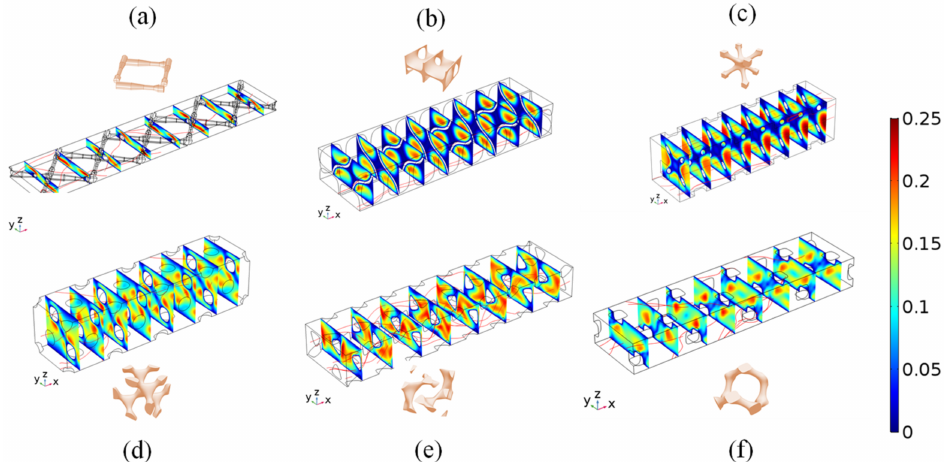
Figure 7. Contours of velocity magnitude (m/s) on eight yz-slices and streamlines at u = 0.1 m/s in ( a ) commercial spacer-filled channel, ( b ) CLP spacer-filled channel, ( c ) IWP spacer-filled channel, ( d ) D spacer-filled channel, ( e ) L spacer-filled channel, and ( f ) IW spacer-filled channel.